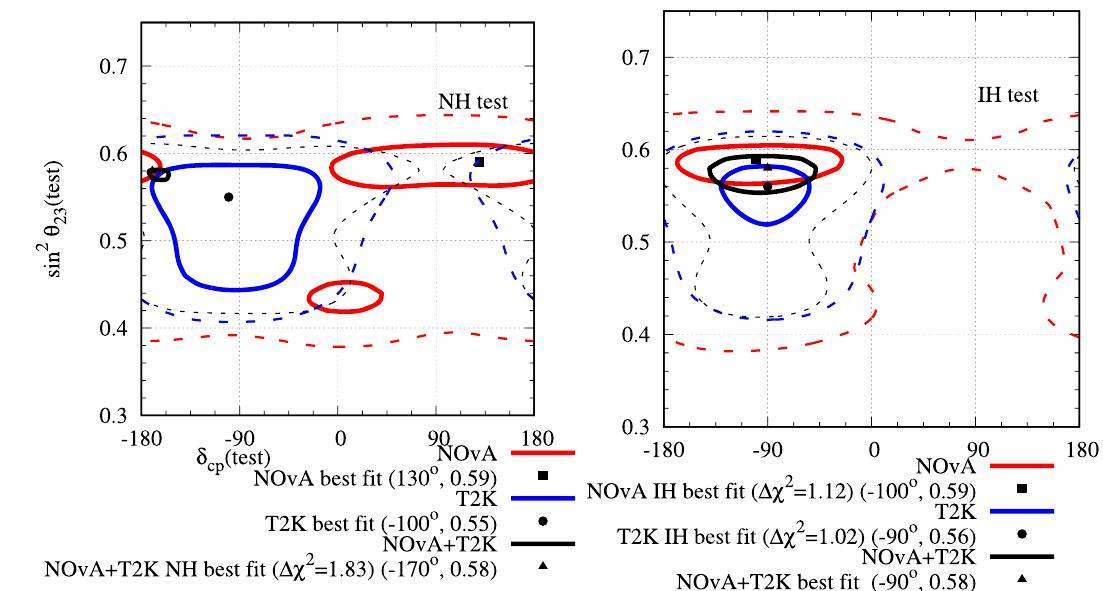
Fig. 17 Allowed region in the sin 2 θ 23 − δ CP plane after analysing NO ν A and T2K complete 2020 data sets with unitary mixing hypothe- sis. The left (right) panel represents the test hierarchy as NH (IH). The red (blue) lines indicate the results for NO ν A (T2K) and the black lines